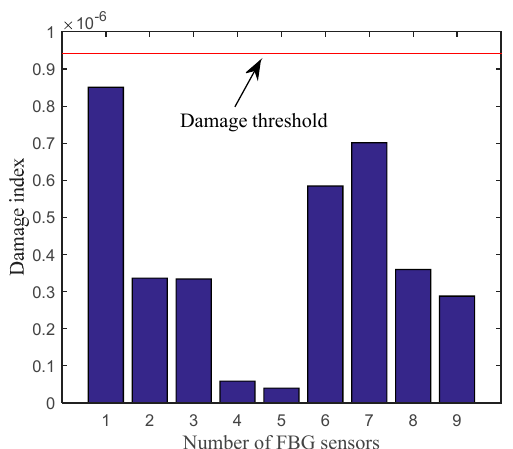
Figure 11. Damage index of plate A.